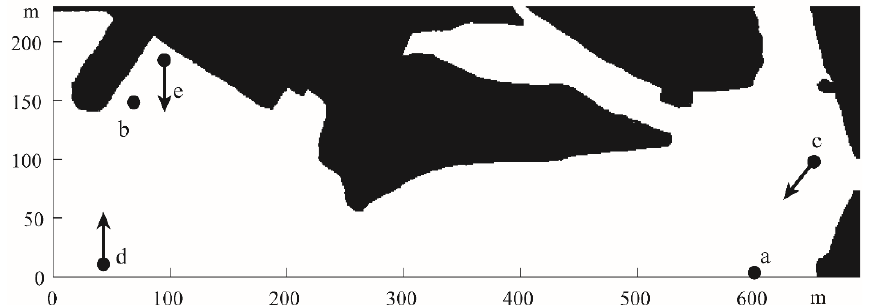
Figure 4. Obstacle settings. W here a and b are the navigation’s starting point and endpoint, respec- tively, and c, d and e are the dynamic obstacles. tively, and c, d and e are the dynamic